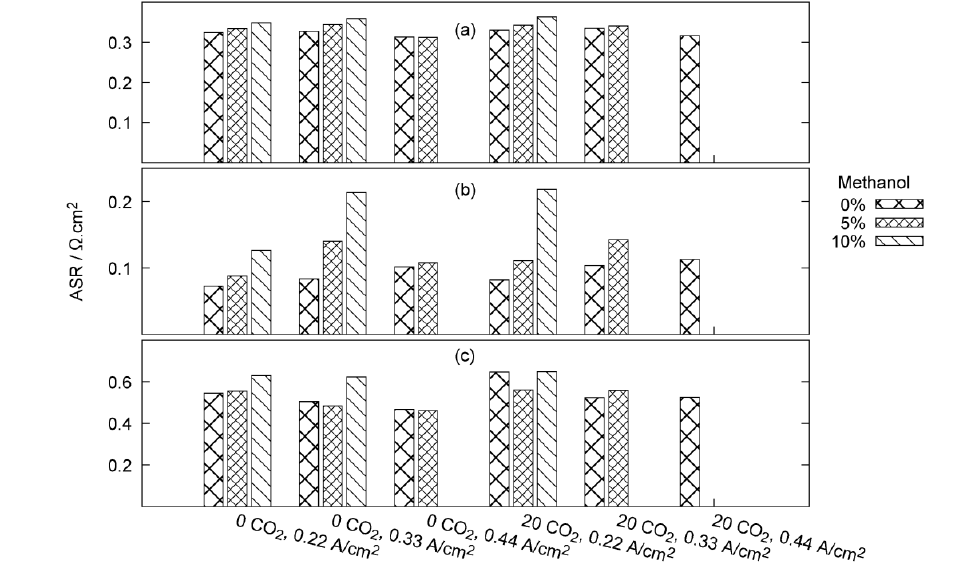
Figure 8. The effect of methanol on a PBI-based HT-PEMFC operating at 160 °C and in the content and current density. ( a ) Ohmic presence of 1% by volume of CO with changing CO 2 resistance; ( b ) High frequency resistance; ( c ) Intermediate -low frequency